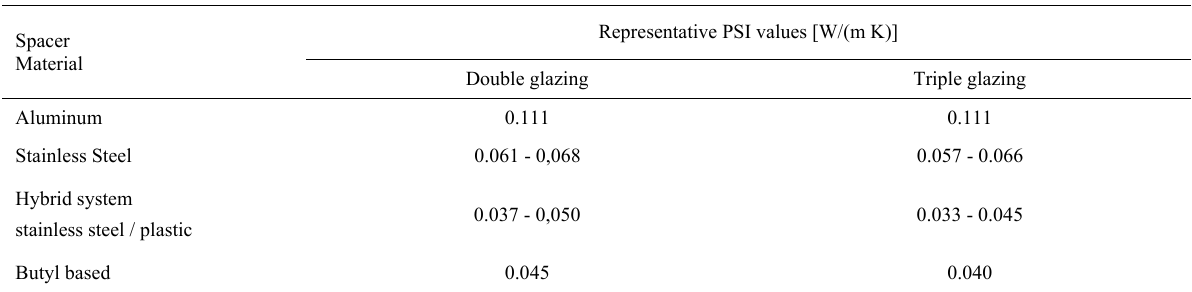
Table 5: Comparison of the PSI values of different spacer systems for a metal window with thermal break (Bundesverband Flachglas 2008)